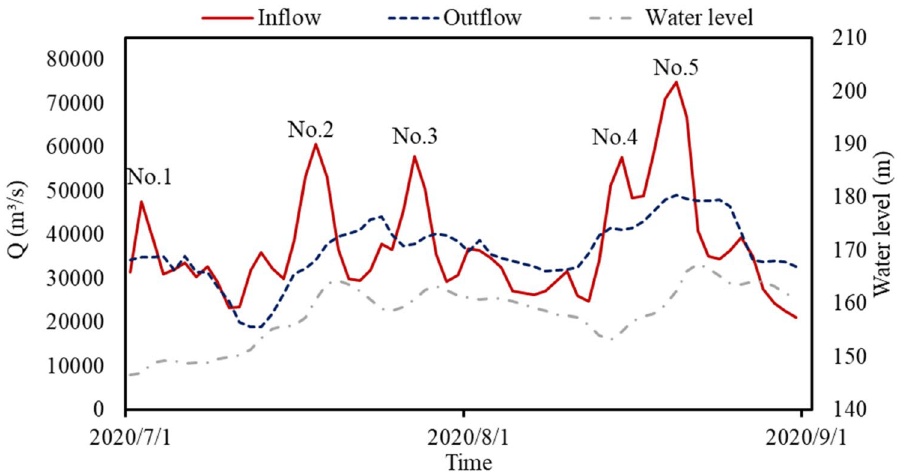
Figure 2. Outflow, inflow, and water level of TGR during 2020 flood